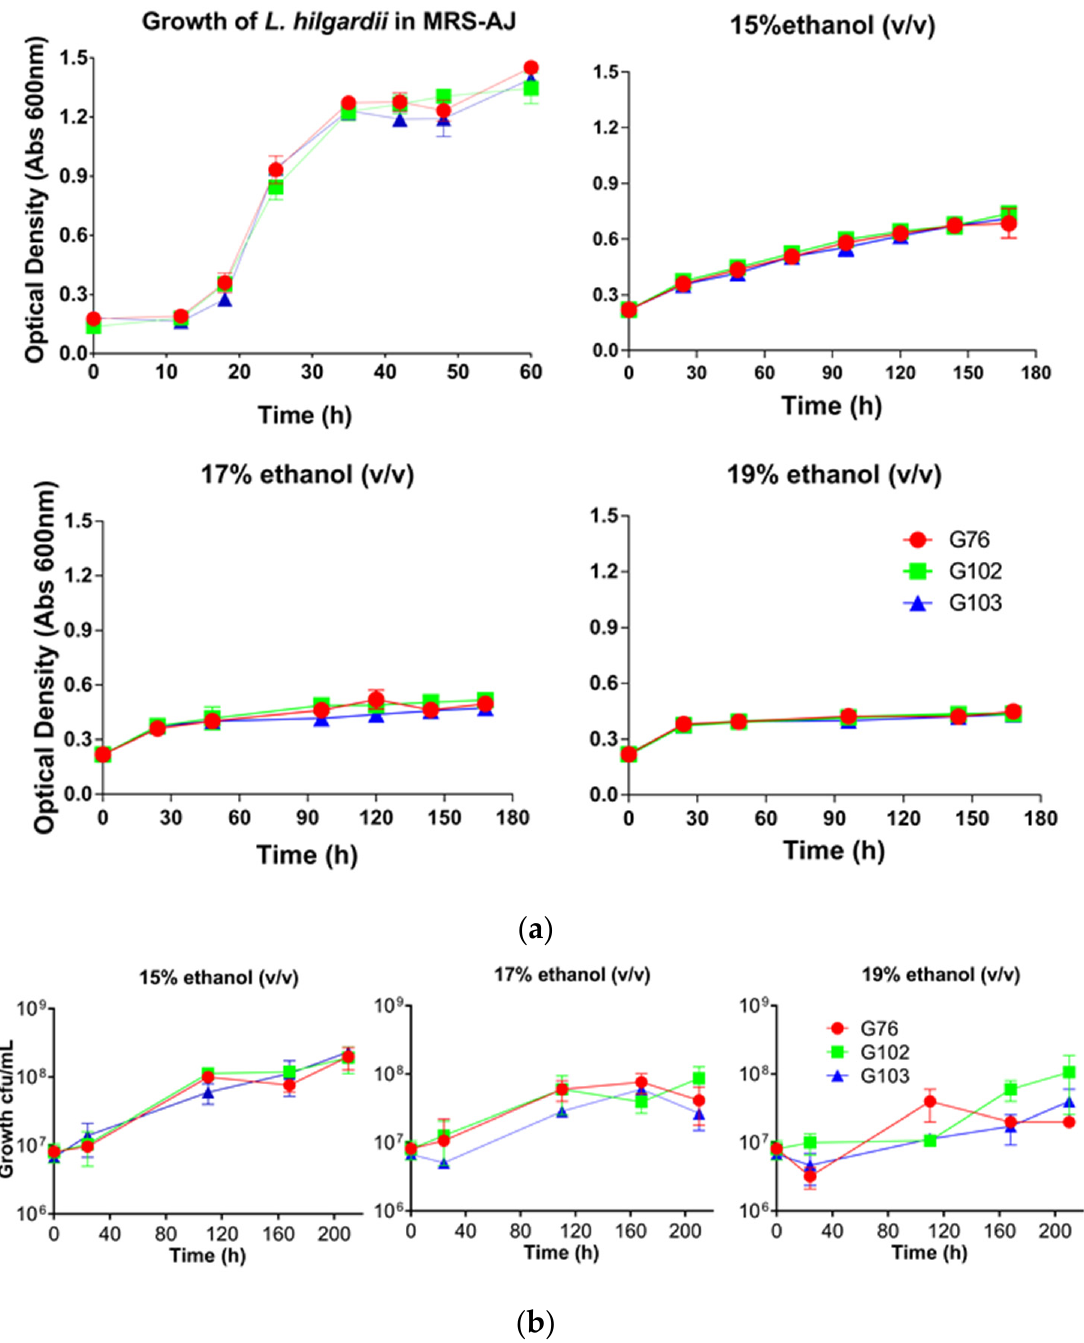
Figure 3. Growth of L. hilgardii isolates in MRS-AJ that contained 15%, 17%, and 19% ethanol respectively, determined by ( a ) Abs 600 ; ( b ) drop plate counting (bars represent one standard deviation ( n = 3)). The growth of various O. oeni (Figure 2a) and L. hilgardii strains (Figure 3a) inoculated into MRS-AJ medium containing 0%, 15%, 17%, or 19% ( v / v ) ethanol was characterized by Abs 600 . Growth was apparent for all strains. Inclusion of ethanol dramatically reduced growth and maximum optical density, with greater inhibition apparent at higher ethanol contents. The greatest resolution of the strains in the presence of ethanol was possible at 15% ( v / v ) ethanol, wherein the strains O. oeni G39 and O. oeni G63 had the fastest growth rate, surpassing the control strain O. oeni VP41 (Figure 2a). O. oeni G50 was the